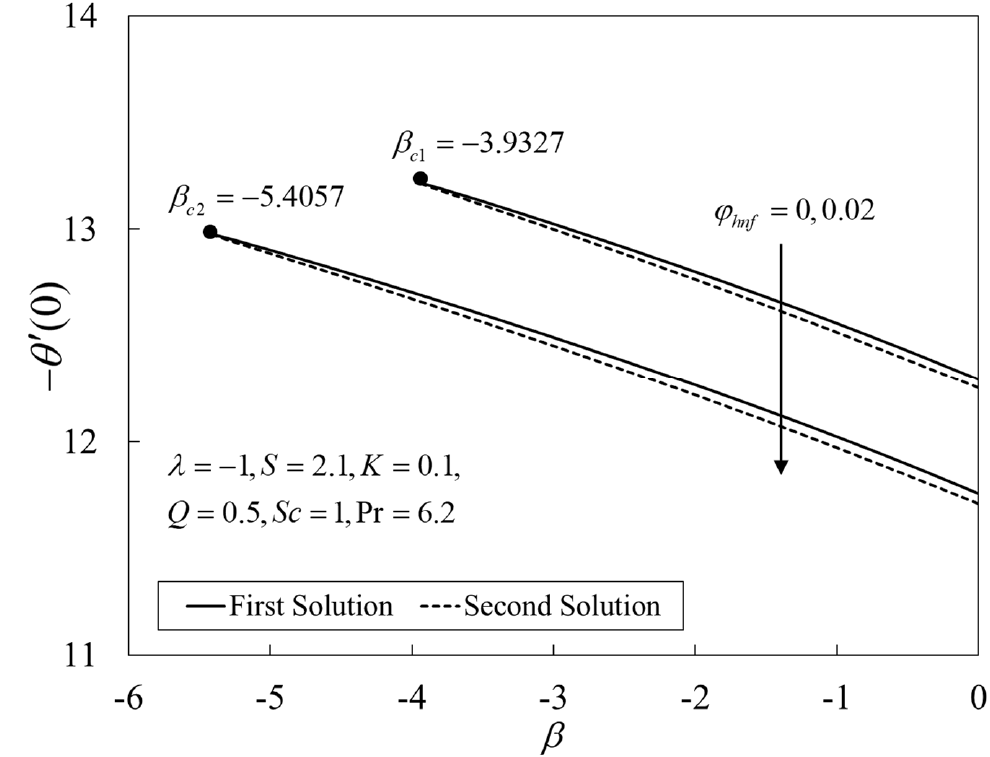
Figure 3. Plot of − θ (cid:48) ( 0 ) against β Figure 3. Plot of (0)  against  .